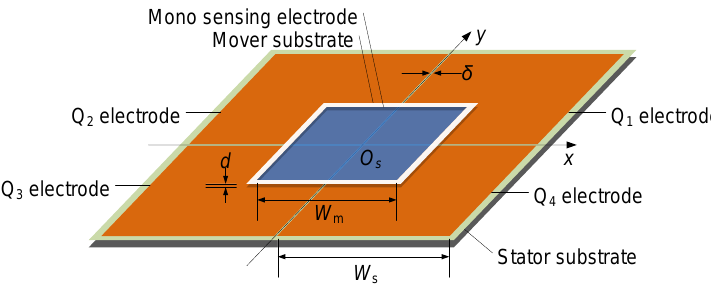
Figure 1. Schematic of the proposed planar position measurement method.